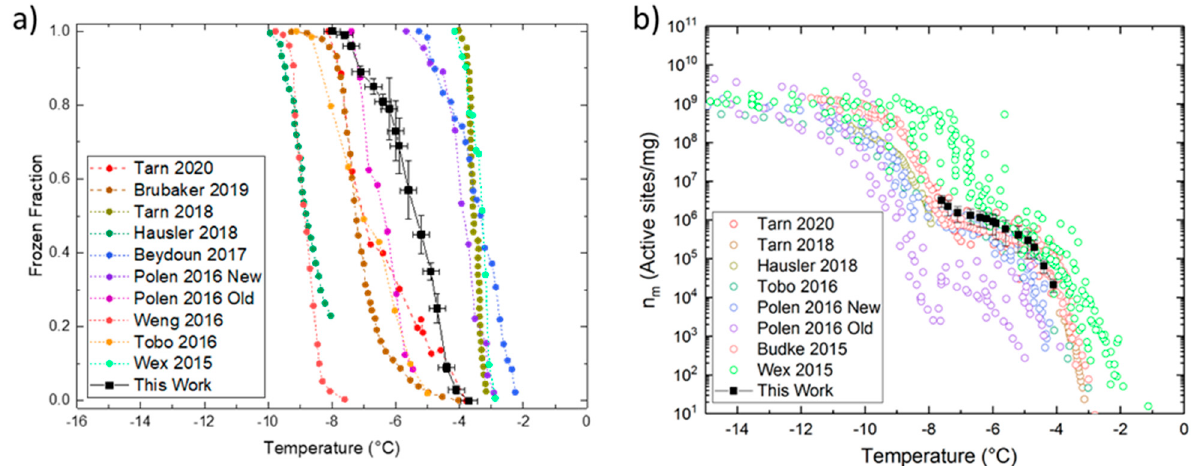
Figure 8. ( a ) Plot showing the frozen fraction of Snomax ® in our microfluidic setup vs. experimental data from literature [42,43,45–47,50,60–62]. The horizontal error bars in the data represent the combined temperature uncertainty of the droplets due to the temperature variation along and across the isothermal channel during experiments. The vertical error bars represent the standard deviation from three independent samples; ( b ) Plots showing the ice nucleation site density per unit mass of Snomax ® and comparison with literature data [36,42,43,47,50,60,61].